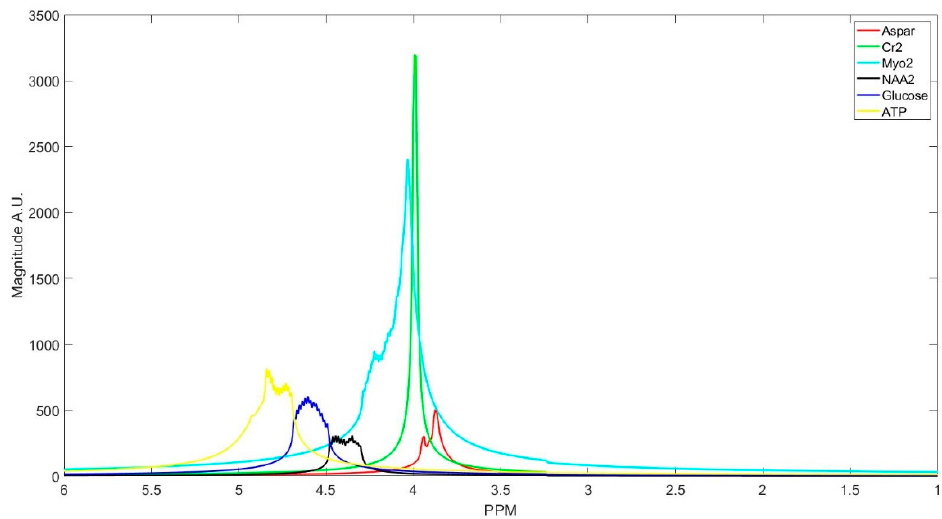
Figure A6. Metabolites listed as group 3 and their corresponding peaks. Figure 11. Metabolites listed as group 3 and their corresponding peaks.